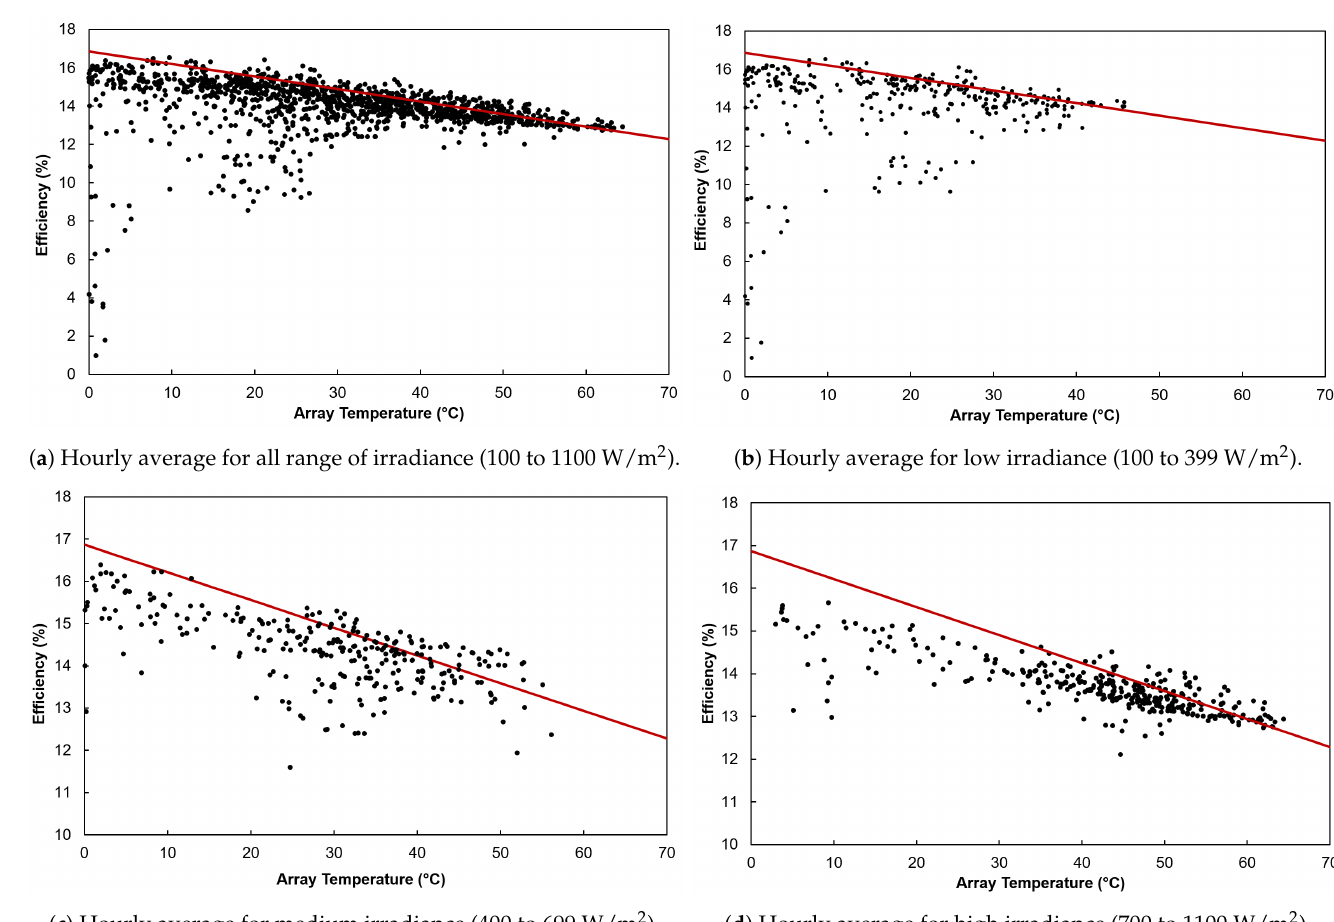
Figure 6. Efficiency vs. array temperature at different wind speeds. The red line is the theoretical efficiency line provided by the manufacturer using Equation